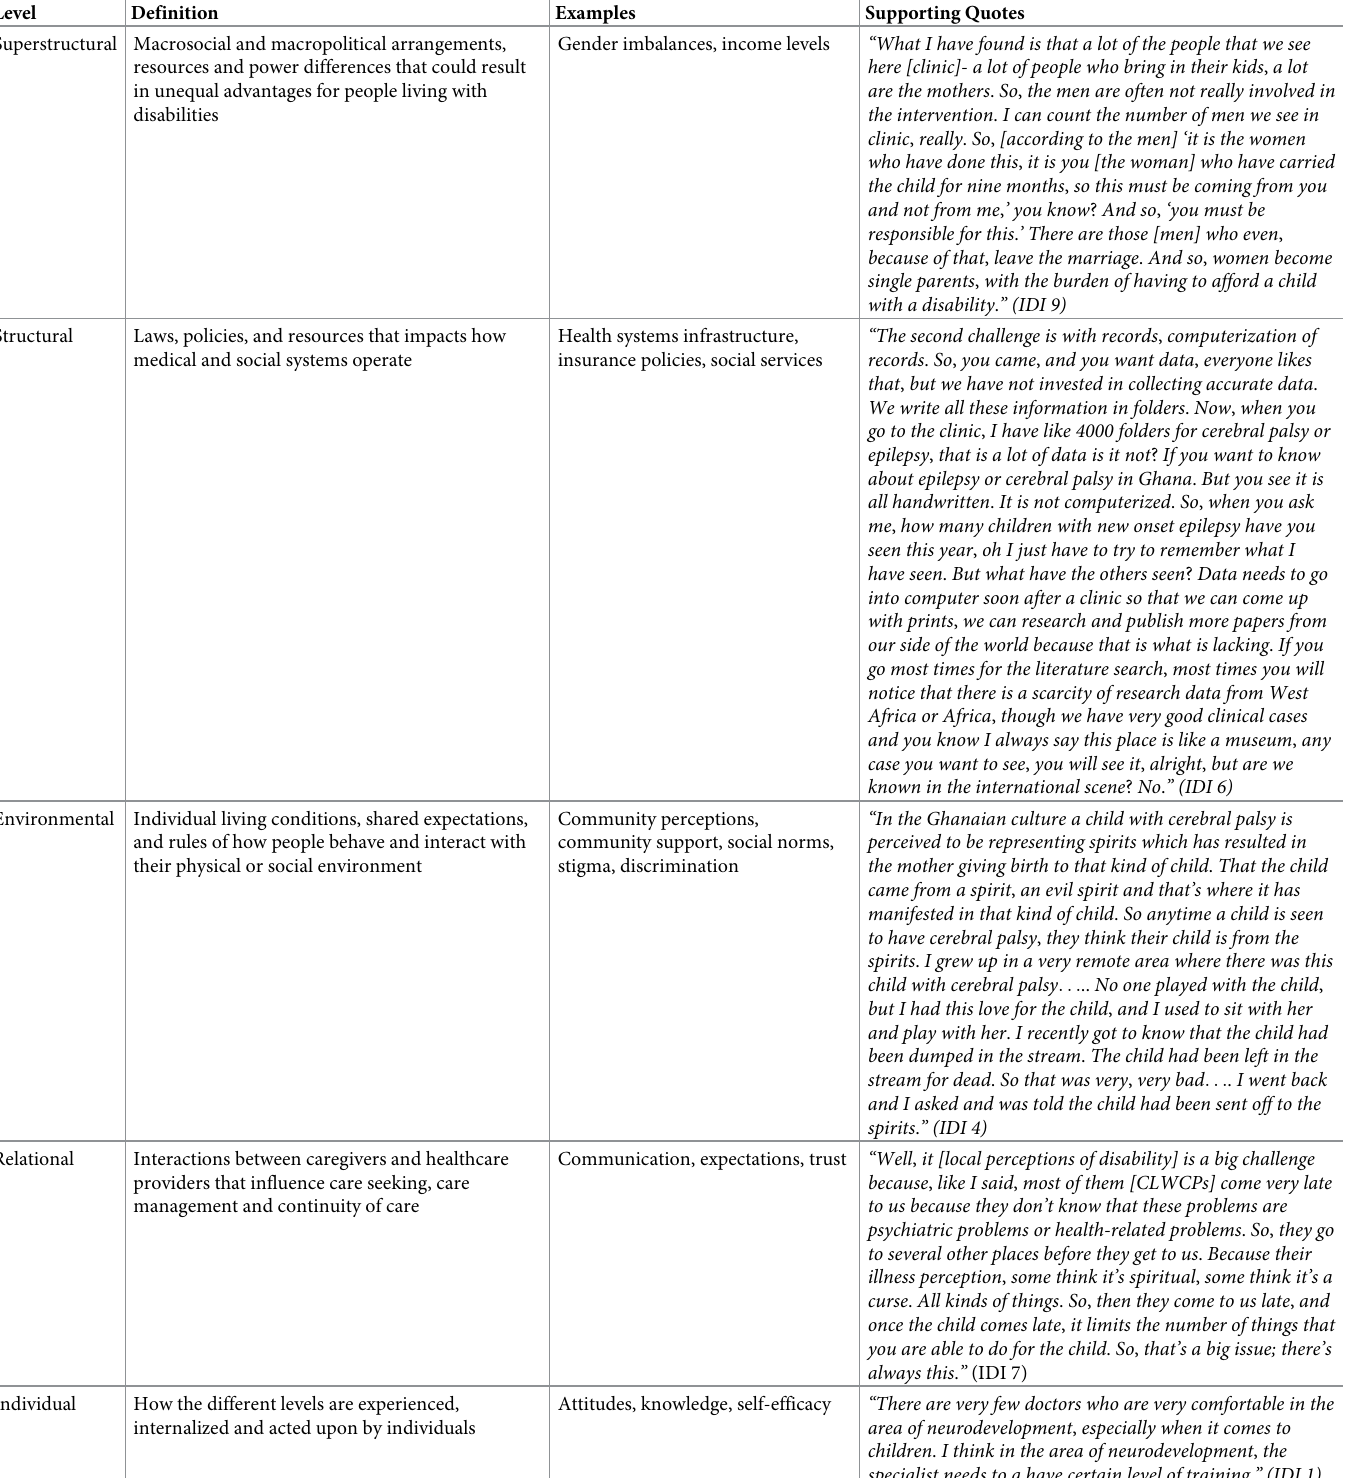
Table 1. Multi-level approach to identifying barriers to testing, diagnosing, referral, and treatment of CLWCPs in Ghana–A social ecological framework adapted from Sweat and